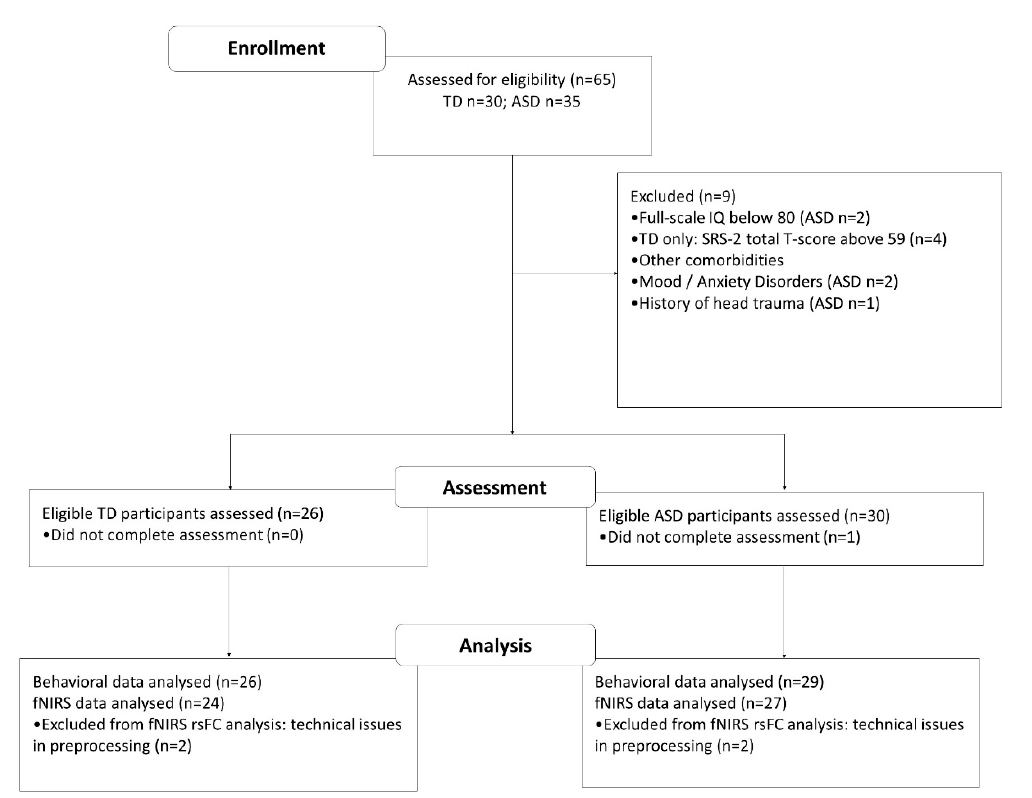
Figure 1. A flowchart showing the participants’ enrollment, assessment, and analysis of this study.